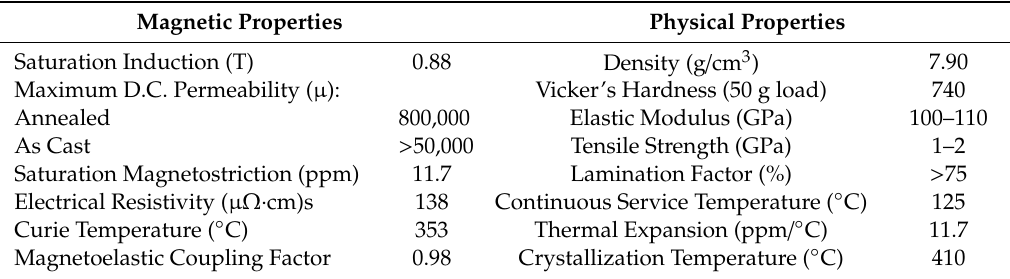
Table 1. Magnetic and physical properties of 2826